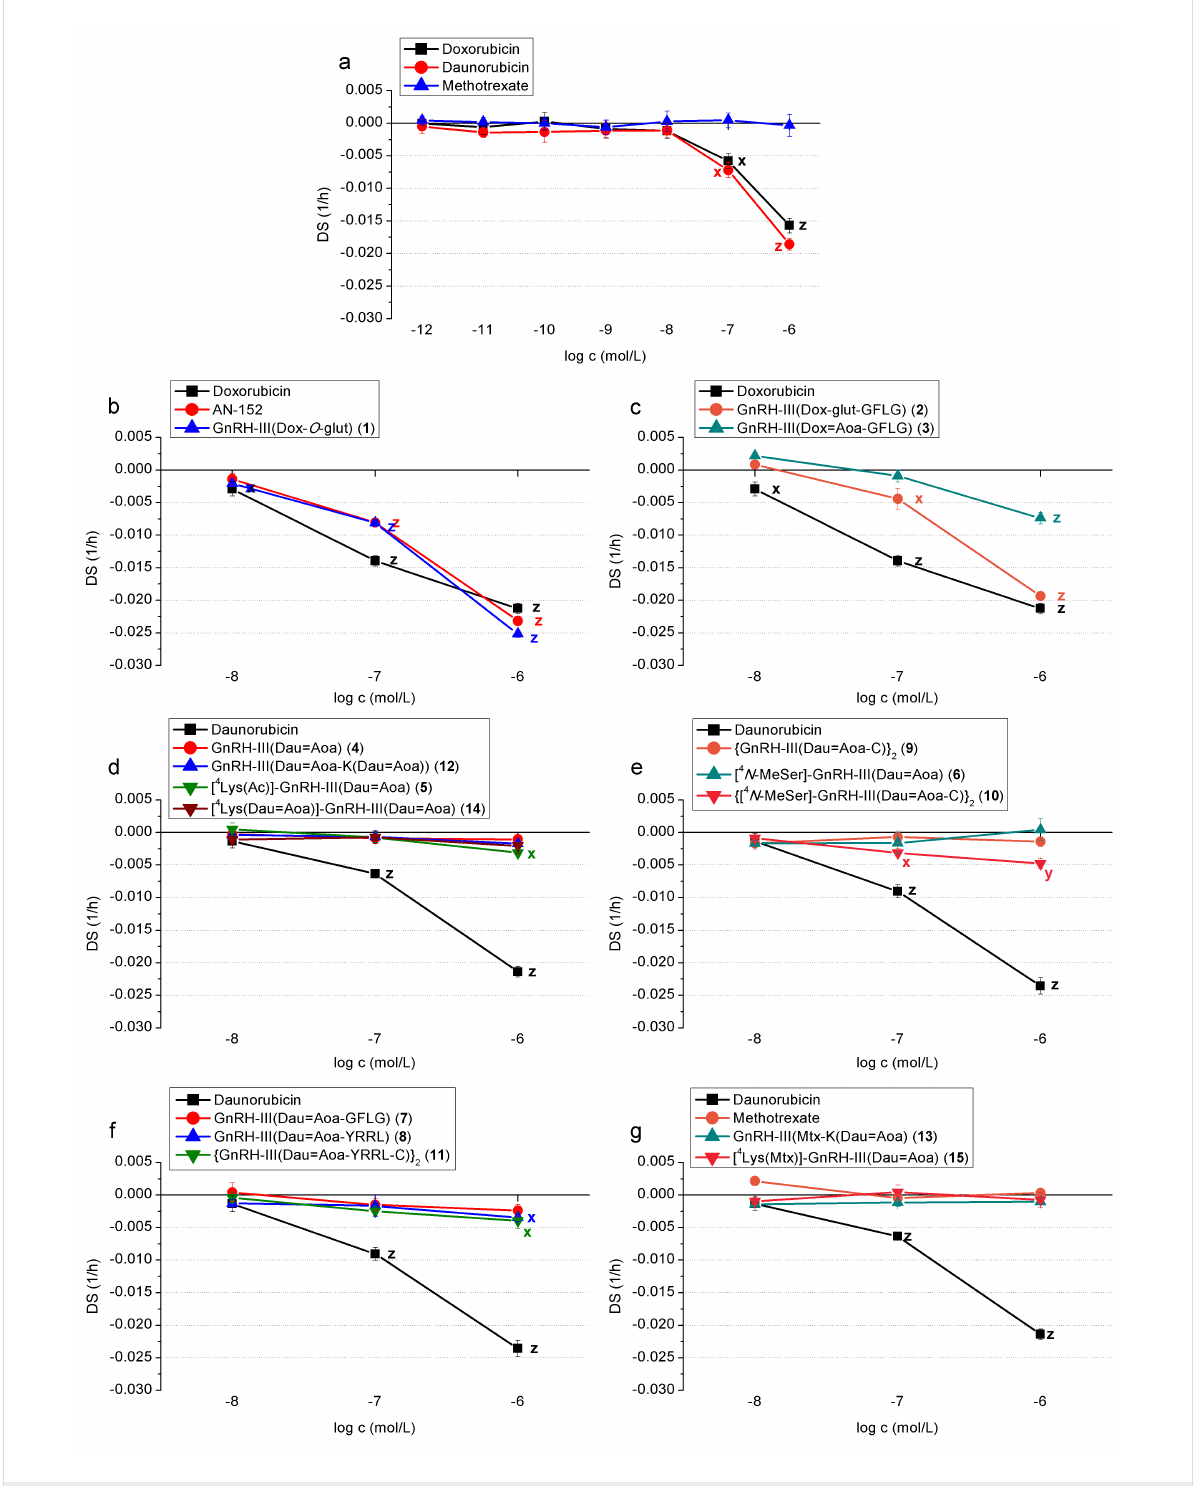
Figure 4: Long-term cytotoxic effects – impedimetrically registered negative effect on cell proliferation and viability – of chemotherapeutic drugs (doxorubicin, daunorubicin, methotrexate) and their GnRH-III conjugates on HCM cells. (a) Chemotherapeutic drugs (doxorubicin, daunorubicin, methotrexate); (b) GnRH conjugates containing doxorubicin without spacer sequence; (c) with spacer sequence GFLG; (d) oxime bond-linked, mono- and bifunctional daunorubicin-GnRH-III conjugates without spacer and modified in position 4 with Lys; (e) {GnRH-III(Dau=Aoa-C)} 2 dimer and conju- gates modified in position 4 with N -MeSer; (f) GFLG or YRRL spacer containing monomer and dimer conjugates; (g) GnRH-III conjugates containing methotrexate and